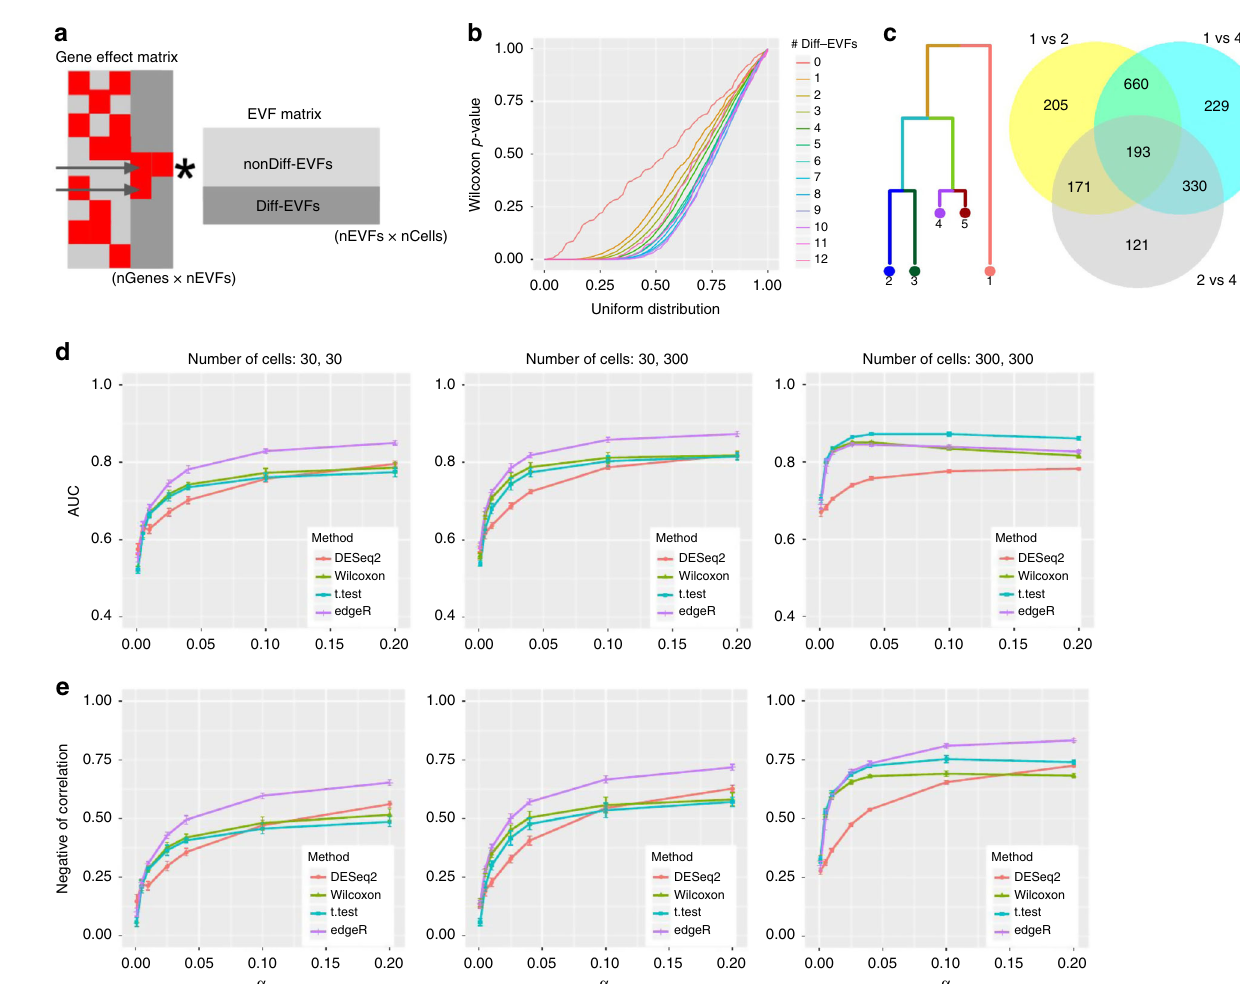
Fig. 6 Benchmarking of DE detection methods. a Illustration of how DE genes are generated through the Diff-EVFs. Red squares in the gene effect matrix correspond to non-zero values. The two genes indicated by the arrows are DE genes by number of Diff-EVFs they have (respectively, 2 and 1). b Q – Q plot comparing the p-value obtained from differential expression analysis between subpopulations 2 and 4 (using Wilcoxon test on the true simulated counts) to a uniform distribution. Genes are grouped by the number of Diff-EVFs they use and different groups are plotted in different colors. The numbers of Diff- EVFs used by genes can be thought of as the degree of DE-ness. Genes with more Diff-EVFs have p-values further diverged from uniform distribution. c Venn diagram showing that closely related populations have less DE genes between them compared to distantly related populations. We use populations 1, 2, 4 as examples: there are much more DE genes from comparison of “ 1 vs 2 ” and “ 1 vs 4 ” than “ 2 vs 4 ” , and DE genes from “ 1 vs 2 ” and “ 1 vs 4 ” have a big overlap. The DE genes are determined by log2 fold change (LFC) of true counts with criterion |LFC| > 0.8. d The AUROC (area under receiver operating characteristic curve) of detecting DE genes using four different methods from observed counts with changing capture ef fi ciency α ( σ = 0.6). The populations under comparison are 2 and 4. Three sets of criteria were used to de fi ne the true DE genes and the fi nal performance was the average performance from the three sets: (1) nDiff-EVFgene > 0 and |LFC| > 0.6; (2) nDiff-EVFgene > 0 and |LFC| > 0.8; (3) nDiff-EVFgene > 0 and |LFC| > 1. LFC was calculated with theoretical means from the kinetic parameters. e The negative of correlation between log2 fold change on theoretical mean of gene- expression and p-values obtained by a DE detection method, with changing capture ef fi ciency α ( σ = 0.6). The populations under comparison are 2 and 4. Data used to plot b , d , e can be found in Source